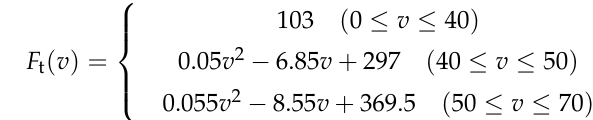
Figure 1. Configurations of the 100% low floor train.